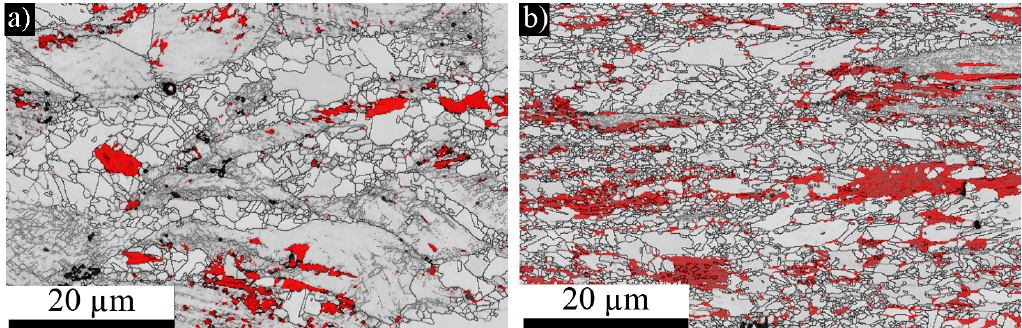
Figure 6. Phase and grain boundary maps (DIM colored in red) after 1 s holding at 700 °C ( a ) 32CR and ( b ) 63CR. Medium-sized and submicron-sized grains with retained DIM and DA.